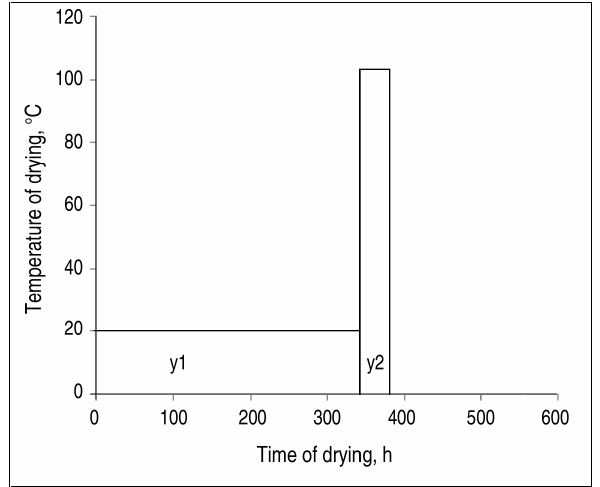
Fig. 1. The evaluation of the relative square measure- ments of drying